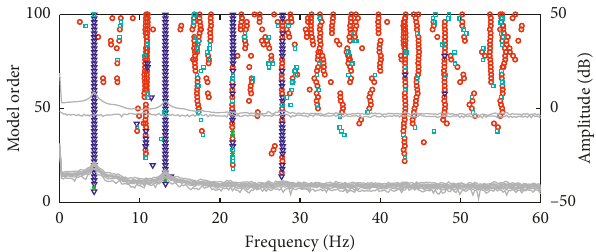
Figure 12: Spectral